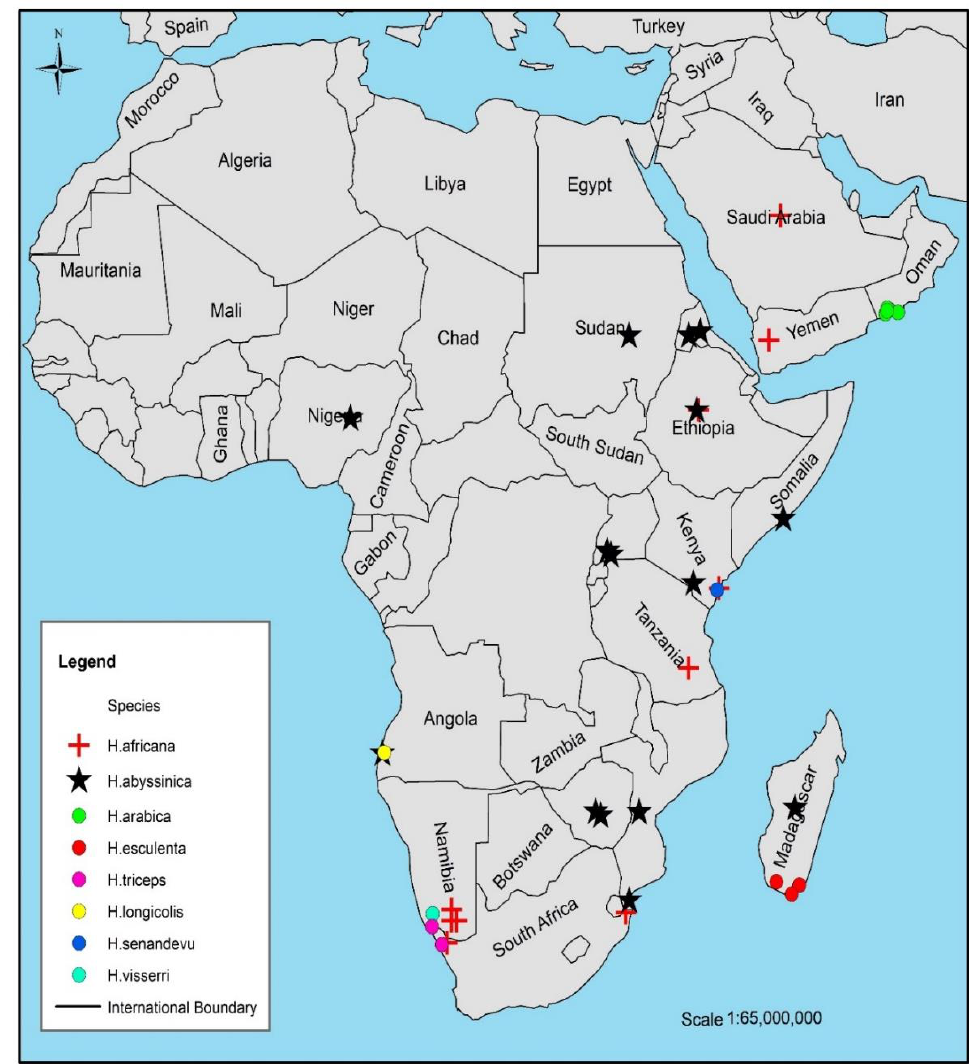
Figure 2. Distribution of Hydnora species in Africa and Arabian Peninsula adapted from [50].